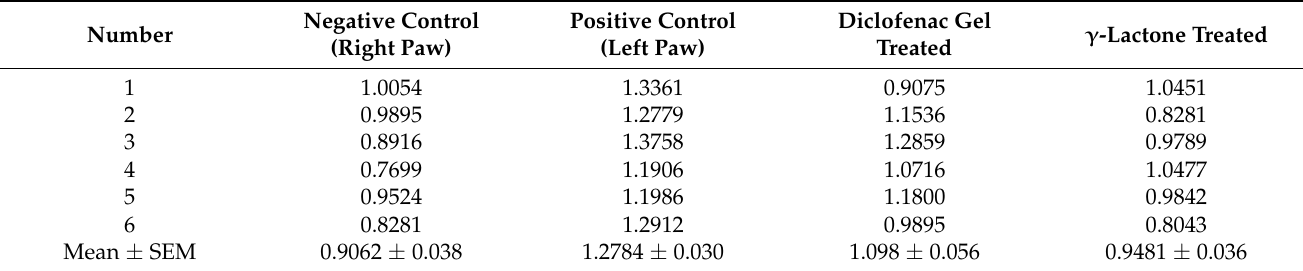
Table 2. The histological changes in skin-thickness measured in (mm) ( n = 24). Diclofenac gel and γ -lactone were applied at 300 mg diclofenac of 1% w / w and 30 mg γ -lactone.